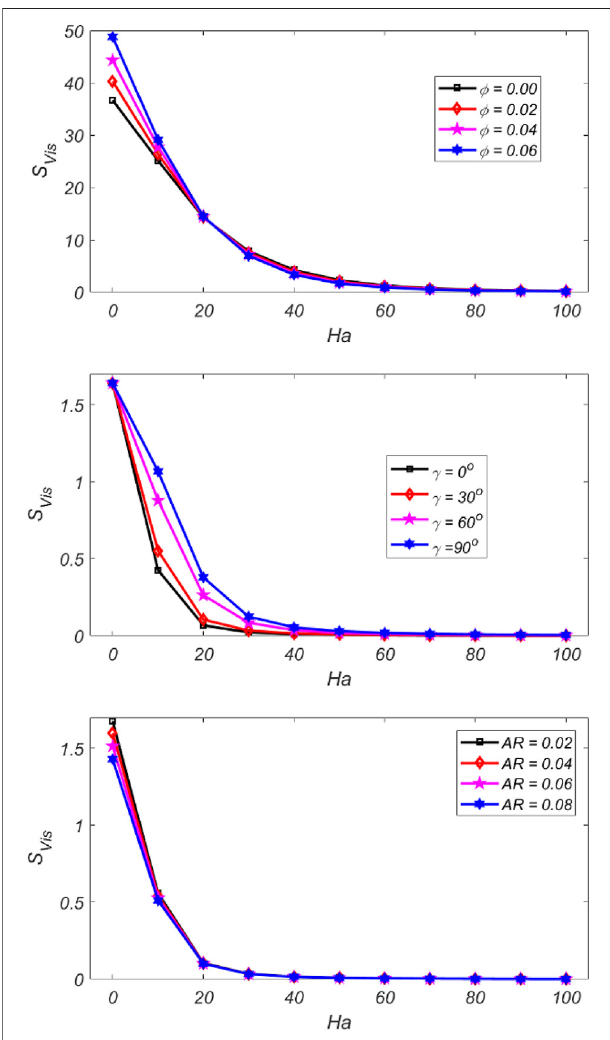
FIGURE 4 | Impacts of Ha on S Ther for various parameters.